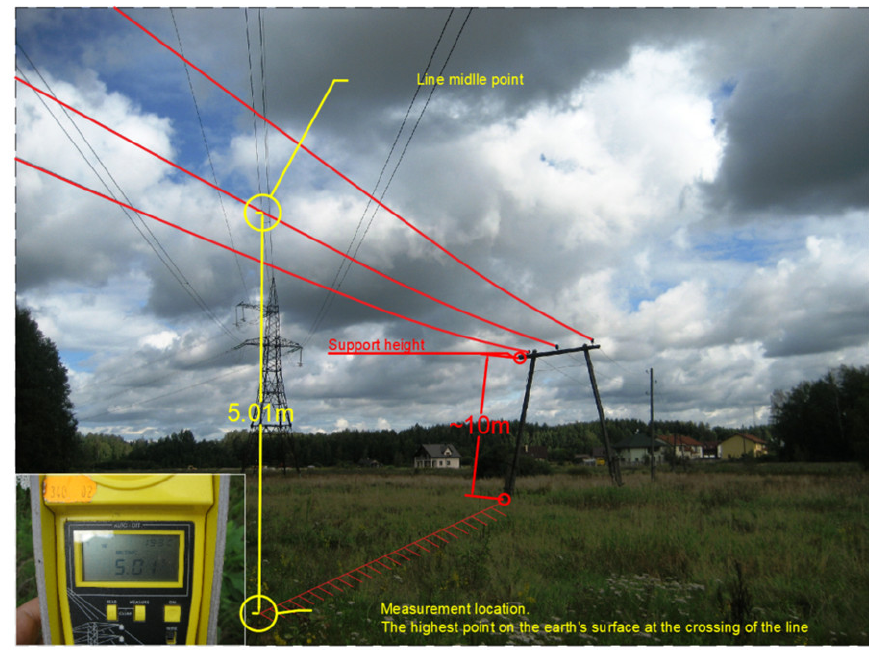
Figure 17. Realization of measurements in the field.